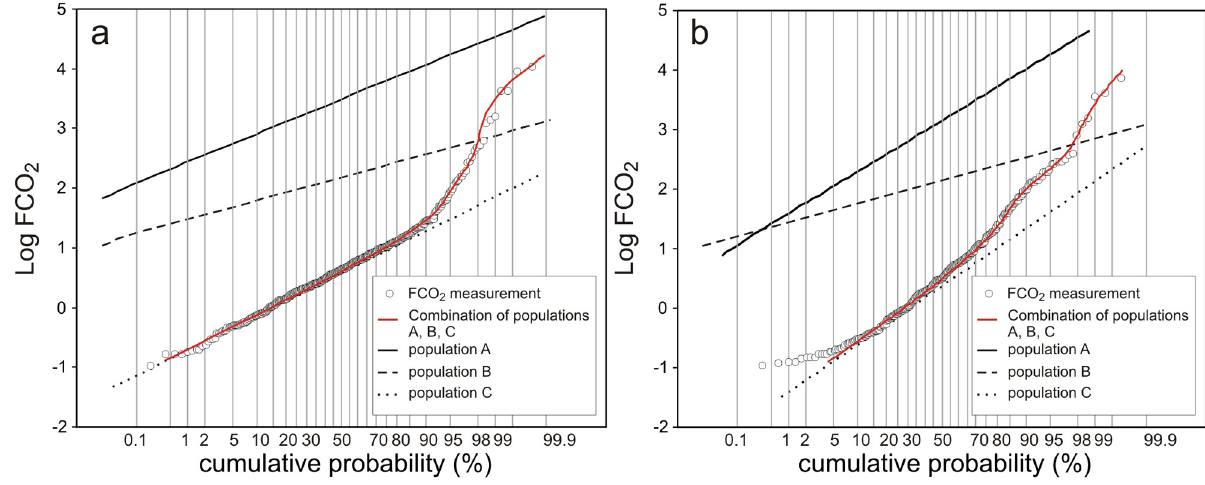
flux for a) October 2006 and b) April-May 2000 survey. The figure shows the original samples (open dots), the Figure 5. Probability plot of CO 2 portioned populations (straight lines) and the computed distribution from the combination of the theoretical populations (coloured lines). Survey Population Proportion (%)